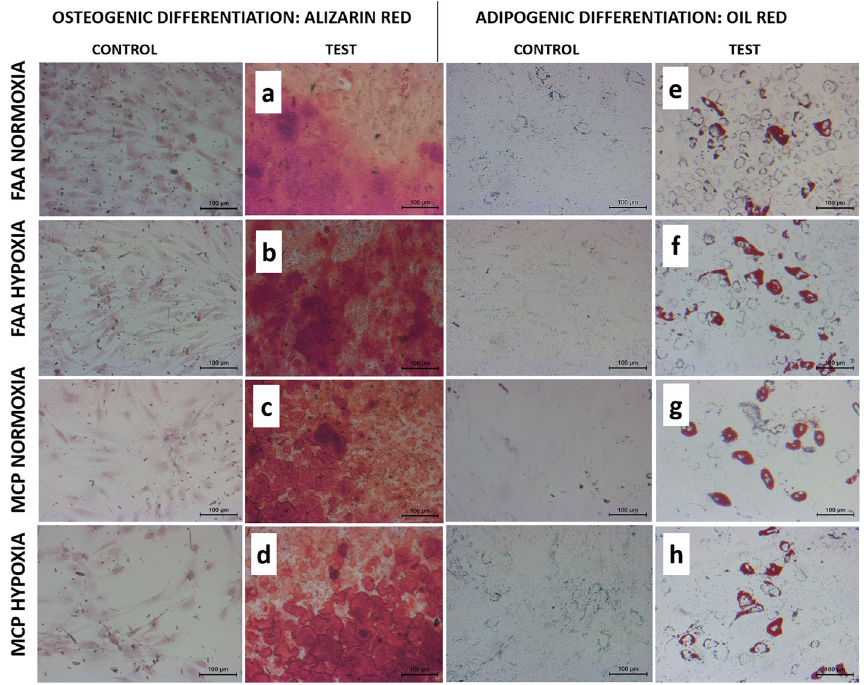
Figure 5. Representative microscopic images of Alizarin red ( a – d ) and Oil Red O ( e – h ) staining to confirm osteogenic and adipogenic differentiation respectively. Magnification: 20X. All groups showed comparable stain uptake confirming the presence of calcium deposition and lipid-droplet formation. Controls did not show any uptake of stain.